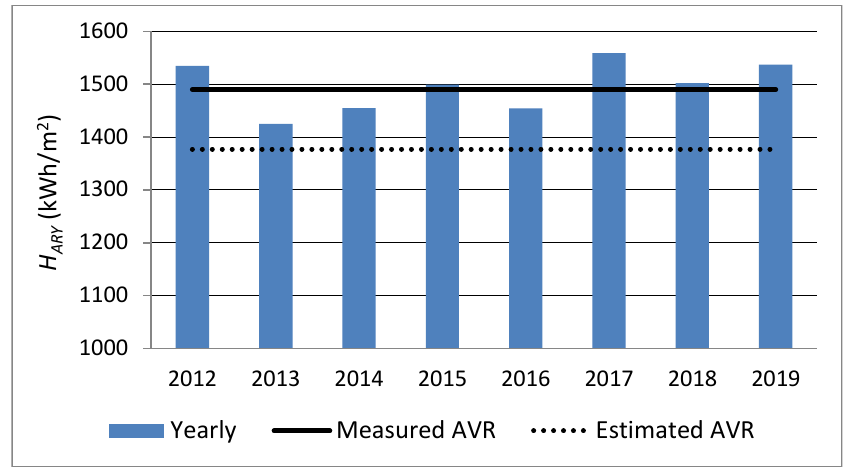
Figure 2. Sum of solar irradiation for every individual year, measured and estimated averages value in analysis period.